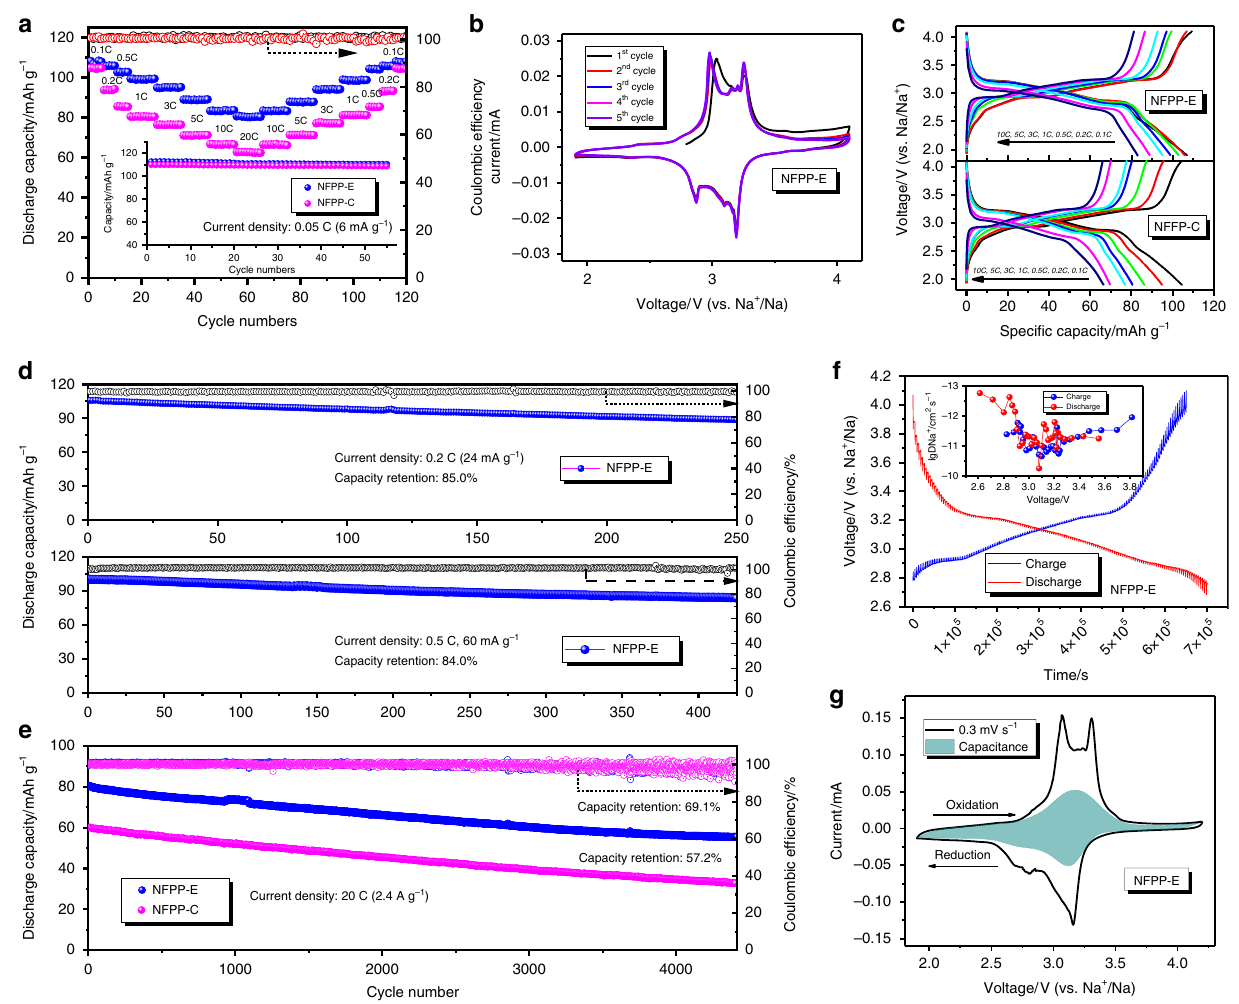
Fig. 2 Electrochemical pro fi les of both samples. a Rate capability of both samples from 0.1 C to 20 C. The inset is the cycling stability at low current density (0.05 C). b Cyclic voltammetry (CV) curves for the fi rst 5 cycles of NFPP-E electrode (scan rate 0.05 mV s − 1 ). c Charge-discharge curves at different rates for both samples. d Cycling stability of NFPP-E electrodes over 250 cycles at 0.2 C and 430 cycles at 0.5 C. e Long-term cycling stability (4400 cycles) at high rate (20 C) for both NFPP-E and NFPP-C electrodes. f Galvanostatic intermittent titration technique (GITT) curves of NFPP-E material for both charge and discharge processes. The inset is the chemical diffusion coef fi cient of Na + ions as a function of voltage calculated from the GITT pro fi le (after 30 cycles, current density: 0.05 C). g The calculated capacitance contribution (shadowed area) to the CV curve of NFPP-E at the scan rate of 0.3 mV s −